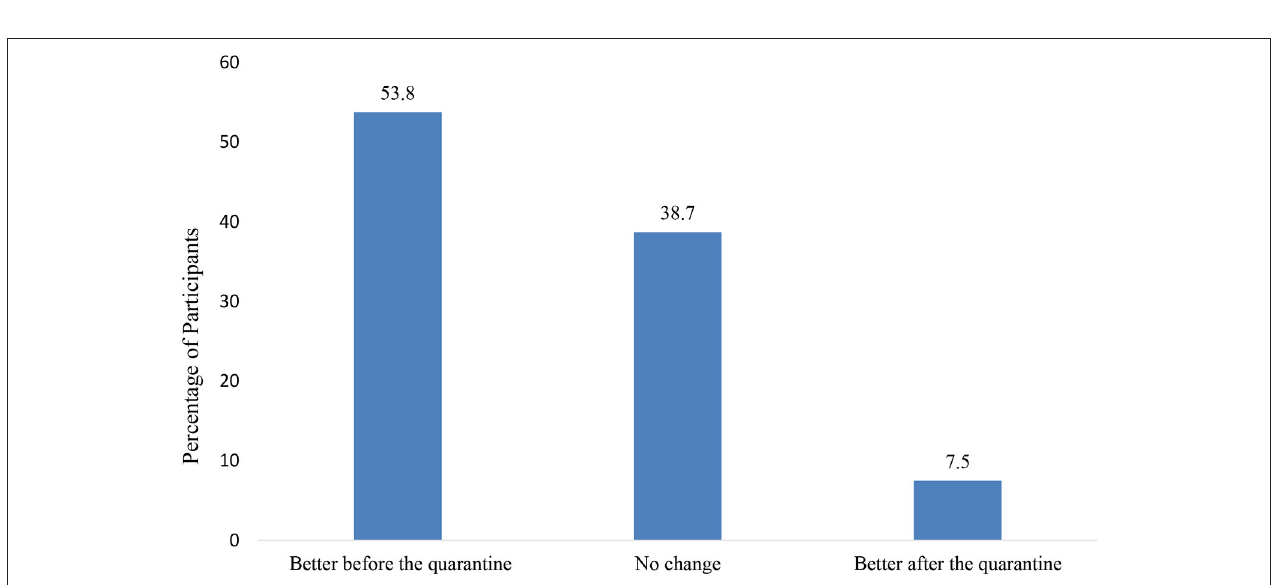
FIGURE 4 | Overall satisfaction of the caregiver or parent with the child’s lifestyle during quarantine (this includes physical activity, sleep, diet, and screen time).